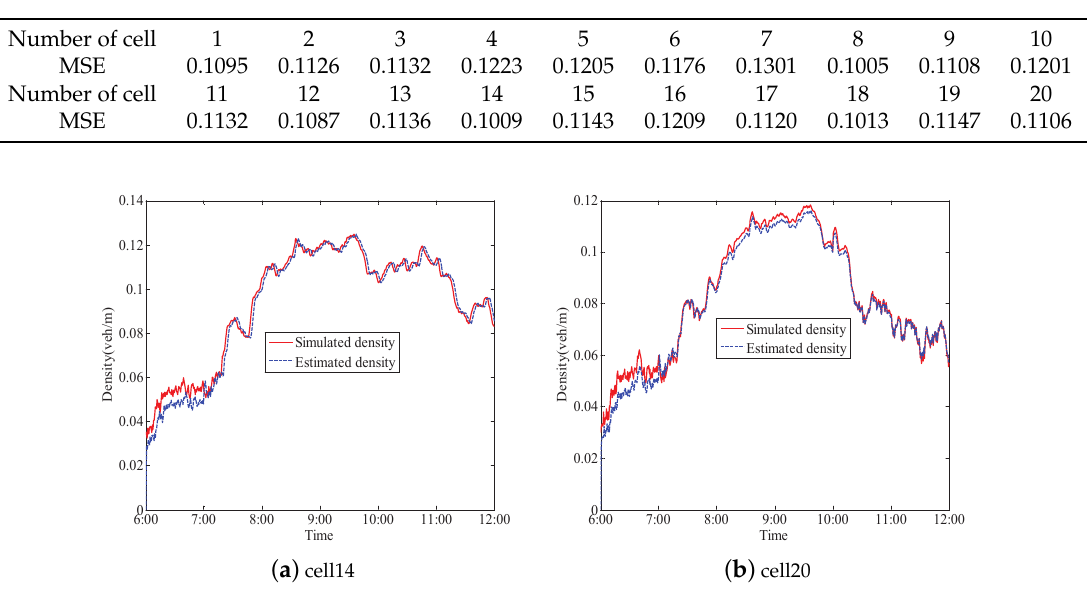
Table 4. Mean square error of estimated densities.